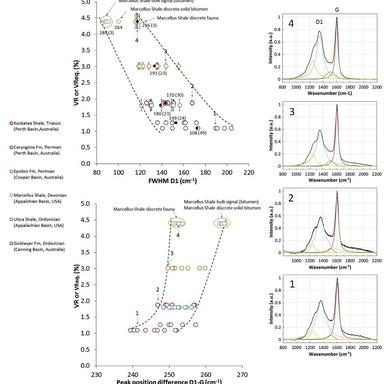
Diagram plotting the FWHM of D1 against VReq of shales. The spectra of carbon from low to high maturity shale (first order region) are shown with the deconvolution into 4 bands following the procedure of The temperatures are average values calculated using all the Raman spectra of the organic matter particles and the standard deviation is indicated in brackets.